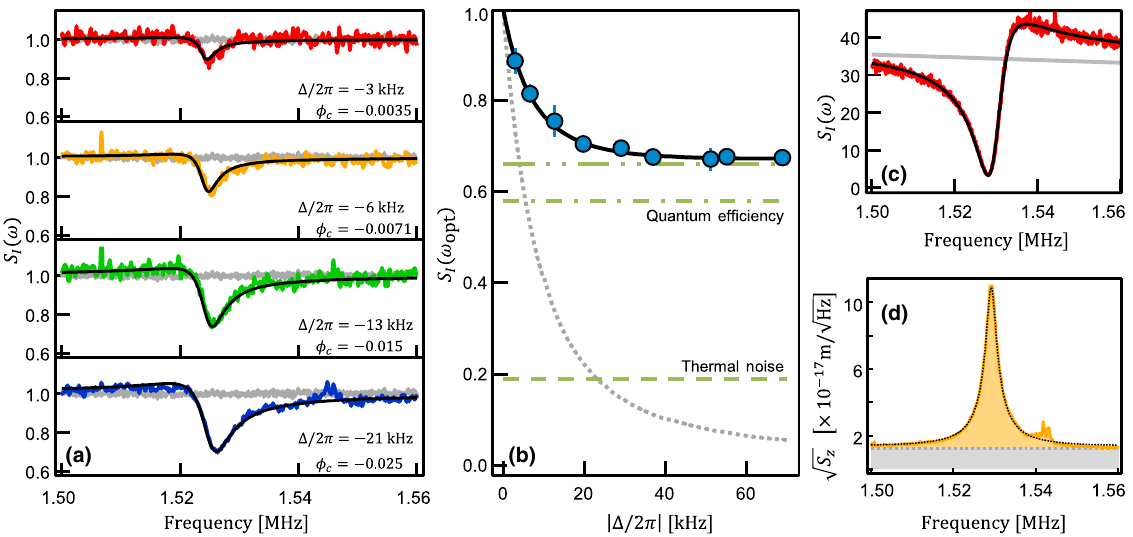
FIG. 2. Quantum intensity noise suppression. (a) Directly detected optical intensity noise signal-beam spectra for several signal- beam detunings. Also displayed are the measured shot-noise level (gray curves) and the theoretical predictions (black curves). A = 2 (cid:4) ¼ 200-Hz bandwidth is used. The ratio of RPSN relative to thermal drive R is fixed at 5.1. The damping beam provides (cid:3) eff 0 = 2 (cid:4) ¼ 1 : 524 MHz . However, the total mechanical damping rate and resonance frequency change with the signal- 2 : 7 kHz and ! eff m for spectra as displayed in (a) (blue circles). Statistical error bars indicate the standard beam detuning (cid:1) . (b) The minimum value of S I shifts with (cid:1) because of the optical spring effect. Also displayed are the deviation. The frequency where the minimum occurs ! opt mechanical thermal noise floor for our current parameters 1 =R (dashed green line), the limit set by finite detection efficiency 1 (cid:4) (cid:7) (dot-dashed green line), the sum of the thermal and detection efficiency limits (dot-dot-dashed green line), and expected squeezing in the absence of optical loss and thermal motion (dotted gray line). (c) The directly detected optical intensity noise signal-beam spectrum with intentionally added white, classical amplitude noise (red curve), theoretical prediction (black curve), and level of added amplitude noise (gray line). (d) The mechanical displacement spectrum inferred from the damping-beam transmission spectrum (orange region) and Lorentzian fit (dotted black line). The detection noise floor is also shown (dotted gray line). One additional peak due to excess noise is visible in the bottom panel of (a) and in (d) at frequencies of approximately 1 : 545 MHz due to a thermally occupied mechanical mode of the cavity support